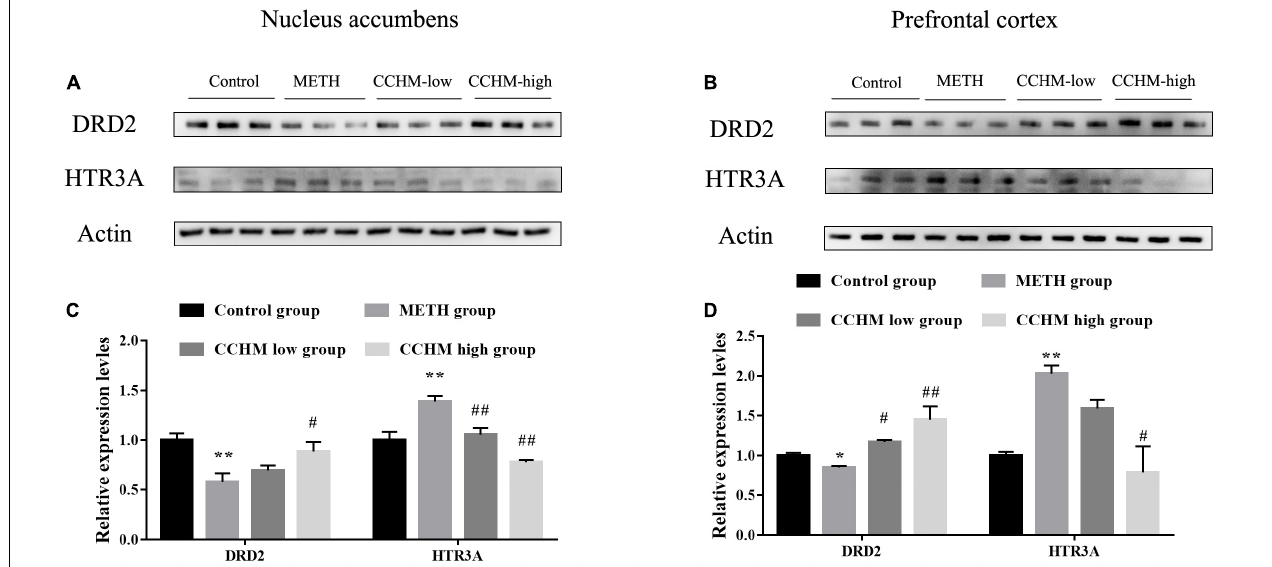
FIGURE 7 | Candidate Chinese herbal medicine (CCHM) administration inhibited methamphetamine (METH)-induced expression changes of D(2) dopamine receptor (DRD2) and 5-hydroxytryptamine receptor 3A (HTR3A) in the nucleus accumbens and prefrontal cortex. (A) Representative bands of DRD2 and HTR3A in the nucleus accumbens. (B) Representative bands of DRD2 and HTR3A in the prefrontal cortex. (C) METH significantly decreased expression of DRD2 and increased expression of HTR3A, while CCHM pretreatment could greatly upregulate DRD2 expression and downregulate HTR3A expression. (D) The expression of DRD2 notably decreased and the level of HTR3A increased in METH group, which could be reverse by CCHM pretreatment. n = 3 for per group, * p < 0.05, ** p < 0.01 compared to the control group, # p < 0.05, ## p < 0.01 compared to the METH group.